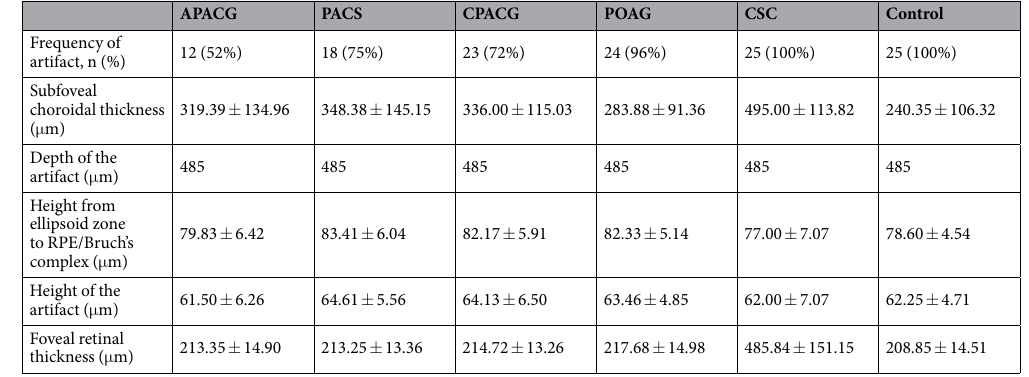
Table 2. Ophthalmologic data (mean ± SD) of study participants.